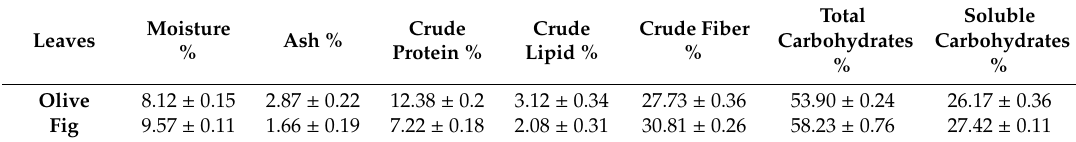
Table 1. Chemical composition of fig and olive leaves on dry-weight basis.